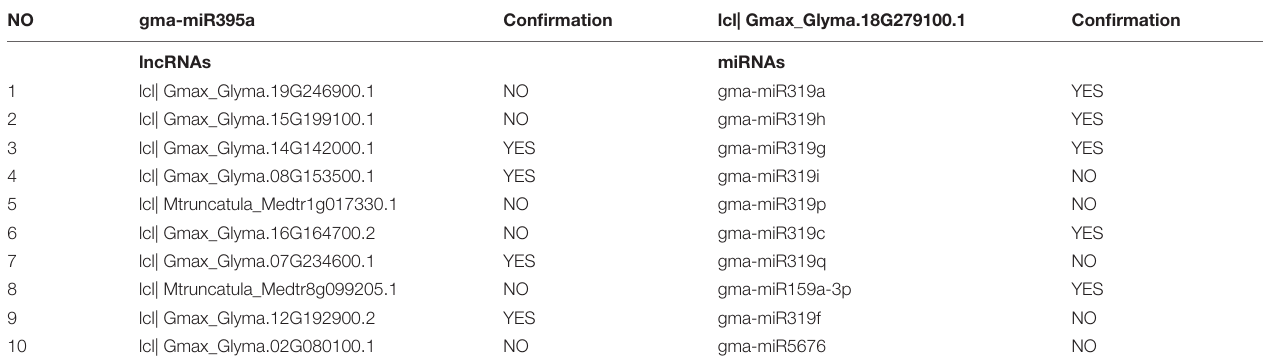
FIGURE 4 | Performance of MILNP’s top-rank predictions, where the X -axis refers to the top 200 to top 2,000 predictions and the Y -axis refers to the recall generated by MILNP. TABLE 5 | Top 10 predictions for miRNA “gma-miR395a” and lncRNA “lcl| Gmax_Glyma.18G279100.1” by